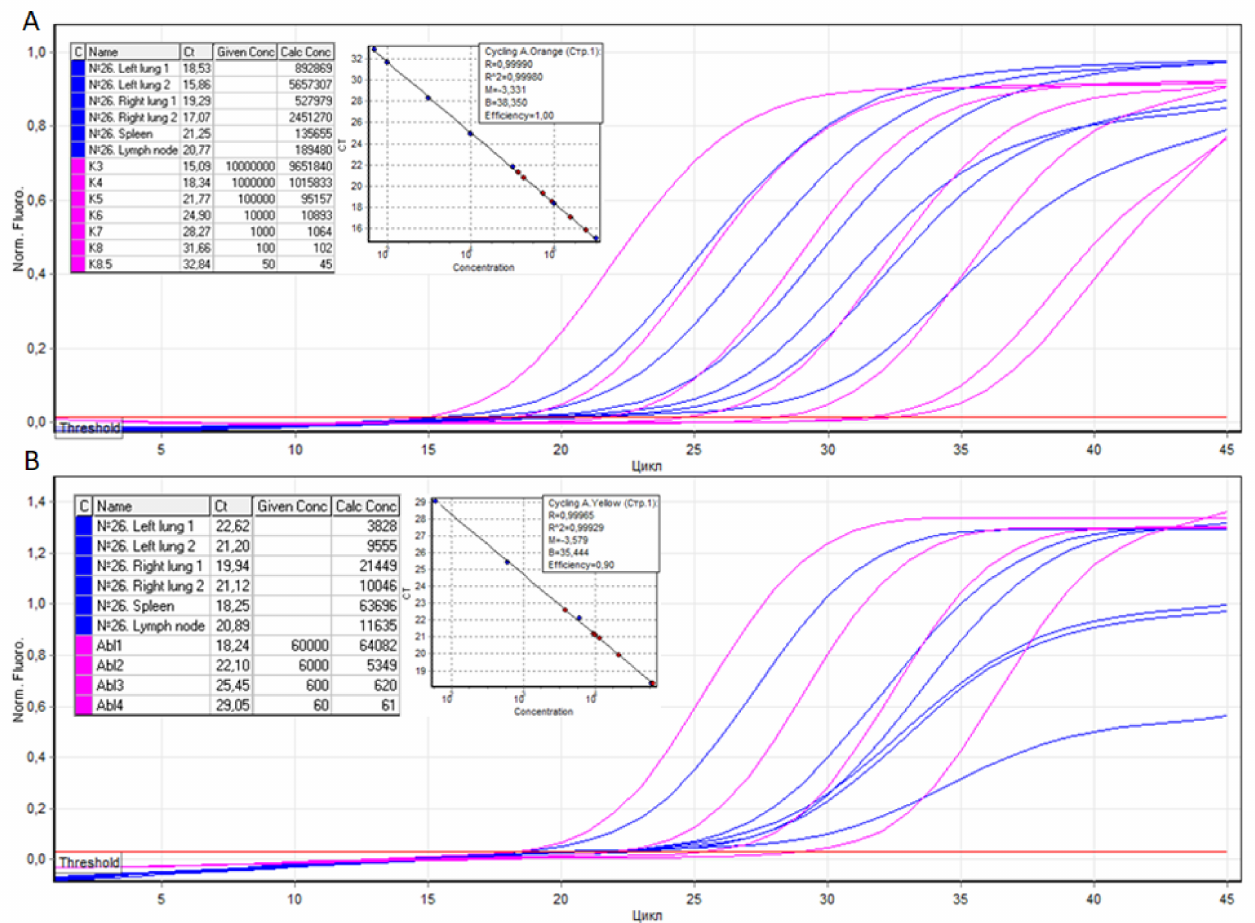
Figure 2. PCR threshold cycles for SARS-CoV-2 and ABL1 cDNAs isolated from the lungs, spleen, and lymph nodes of Patient 26. ( A ) The number of SARS-CoV-2 cDNA copies (with R 2 = 0.99980 and an efficiency of 1.00) of the left and right lung tissue samples were 892,869, 5,657,307, and 527,979, 2,451,270, respectively. The number of SARS-CoV-2 cDNA copies of the spleen and lymph node tissue samples was 135,655 and 189,480, respectively. ( B ) The number of ABL1 cDNA copies (with R 2 = 0.99929 and an efficiency of 0.90) of the left and right lung tissue samples were 3828, 9555, and 21,449, 10,046, respectively. The number of ABL1 cDNA copies of the spleen and lymph node tissue samples was 63,696 and 11,635,